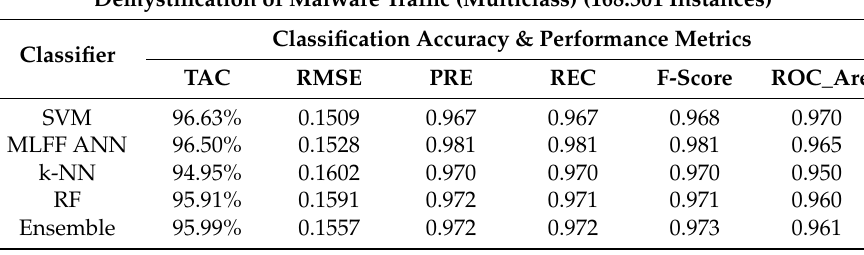
Table 2. Comparison between